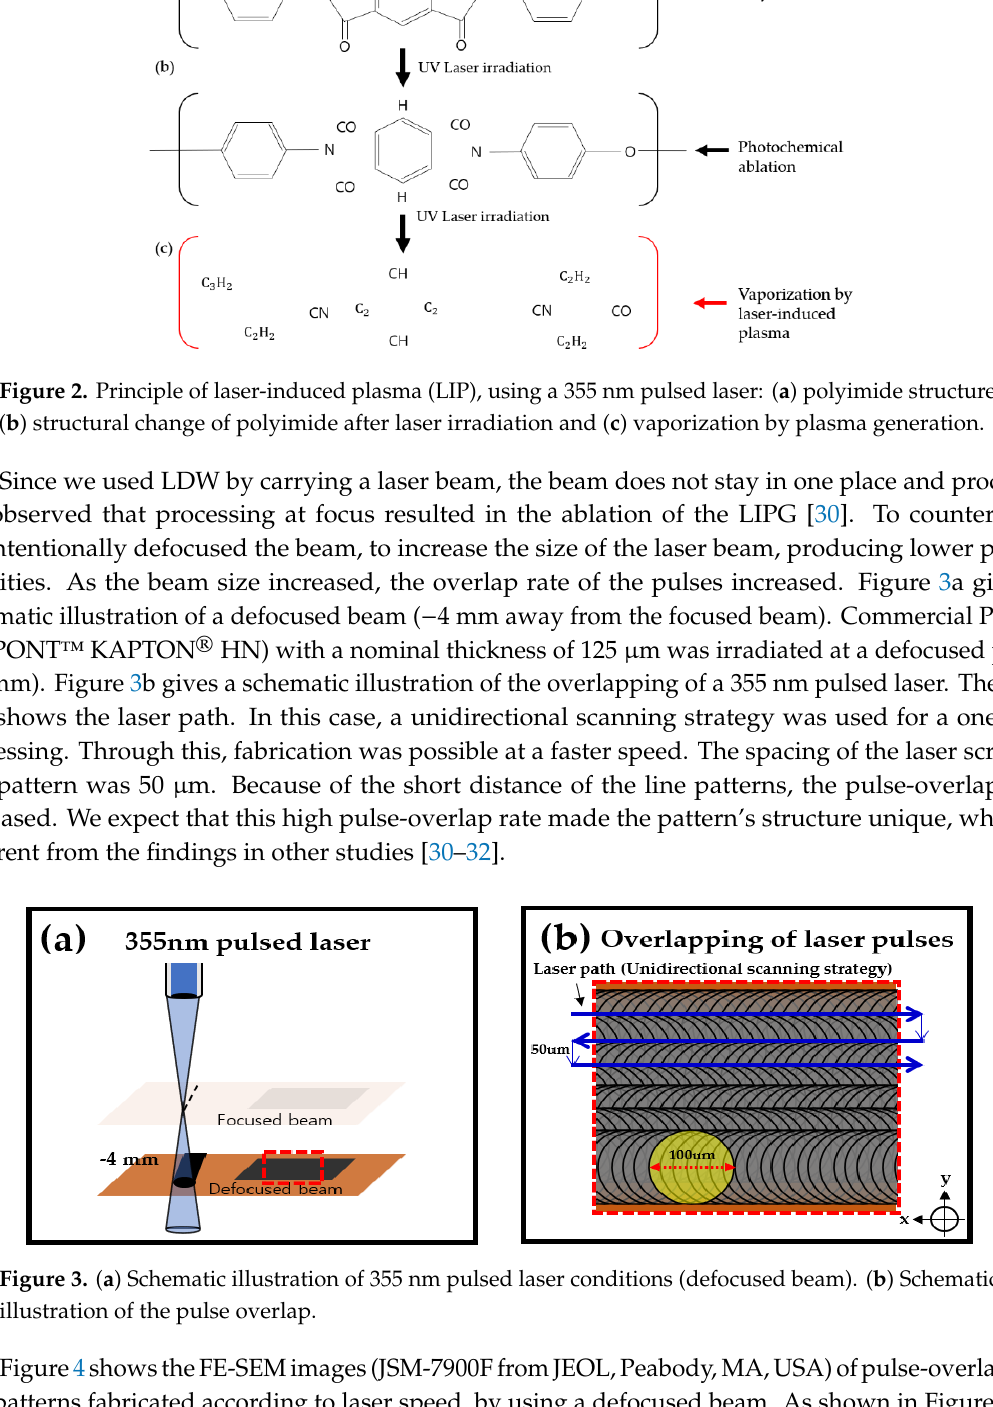
Figure 2. Principle of laser-induced plasma (LIP), using a 355 nm pulsed laser: ( a ) polyimide structure,